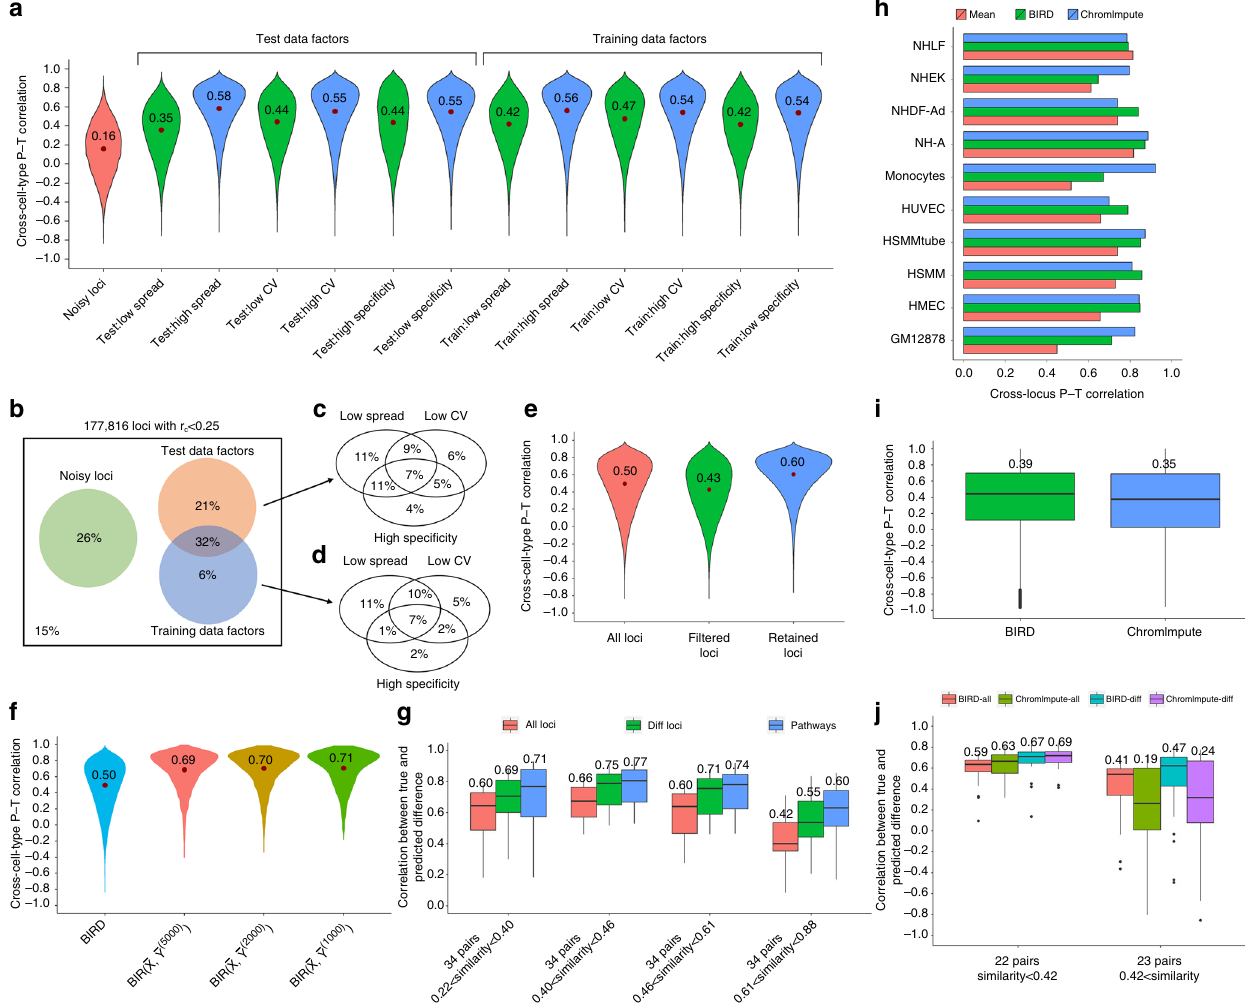
Fig. 3 Cross-cell-type prediction performance and a comparison with ChromImpute. a Distribution and mean of r C for different loci classes. DHSs were categorized into noisy loci and non-noisy loci based on test data (Supplementary Methods). The non-noisy loci were divided into two groups (low or high) based on different factors: max – min spread, coef fi cient of variation (CV), cell-type-speci fi city. The grouping was done separately using the true DH values from the test data and from the training data. b – d Percentage of loci with low cross-cell-type prediction accuracy ( r C < 0.25) explained by noisy loci, low max – min spread, low CV, high cell-type-speci fi city in test cell types (details shown in c ) and training cell types (details shown in d ). e Distribution of r C for all loci, loci fi ltered out by factors in ( b ) (i.e., noisy loci, low max-min spread, low CV, or high cell-type-speci fi city), and the remaining loci. f Comparison between locus-level and pathway-level predictions in terms of cross-cell-type prediction accuracy. For each method, r C distribution of all genomic loci or pathways (5000, 2000, and 1000) are shown. g Accuracy for predicting differential DH between two cell types. The 136 pairs of test cell types were strati fi ed based on the quartiles of the similarity between the two compared cell types. For each stratum, the distribution and mean of the prediction – truth Pearson ’ s correlation across all loci, differential loci, and DHS pathways (1000) are shown. h – j Comparison between BIRD and ChromImpute using 10 test cell types. h Cross-locus P – T correlation r L . As a baseline, predictions based on the mean DH pro fi le of training cell types are shown. i Cross-cell-type P – T correlation r C . j Accuracy for predicting differential DH between two cell types. Test cell type pairs were divided into two groups based on the median of similarity between the two compared cell types. For each group, the distribution and mean of the prediction – truth correlation across all loci and differential loci are shown. ( g , i , j ) The boxplots show median (central line), interquartile range (IQR, the 1st (Q1) to 3rd (Q3) quartiles, box), and 1.5 × IQR from the Q1 and Q3 (lower and upper whiskers),